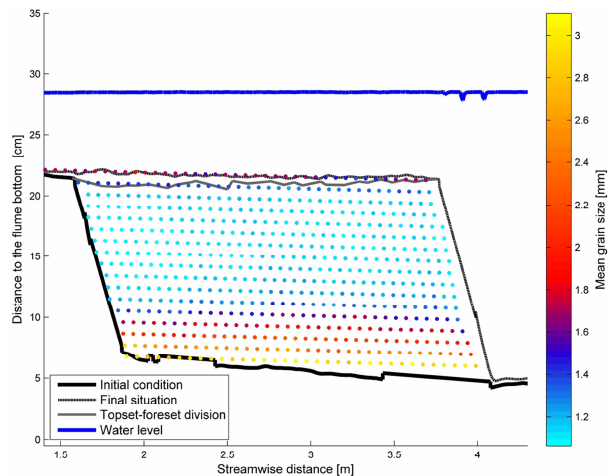
Figure 15. Size stratification within a Gilbert delta deposit mea- Figure 15 Size stratification within a Gilbert delta deposit measured using the stratigraphy sured using the stratigraphy measurement technique proposed in measurement technique proposed in this paper. The colours indicate the local mean grain size this paper. The colours indicate the local mean grain size based on areal fraction based on areal fraction content.